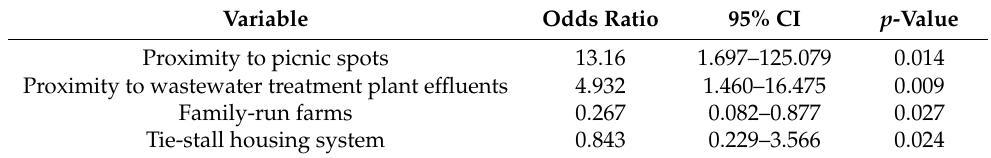
Table 2. Factors associated with farms found infected with bovine cysticercosis in North-West Italy.